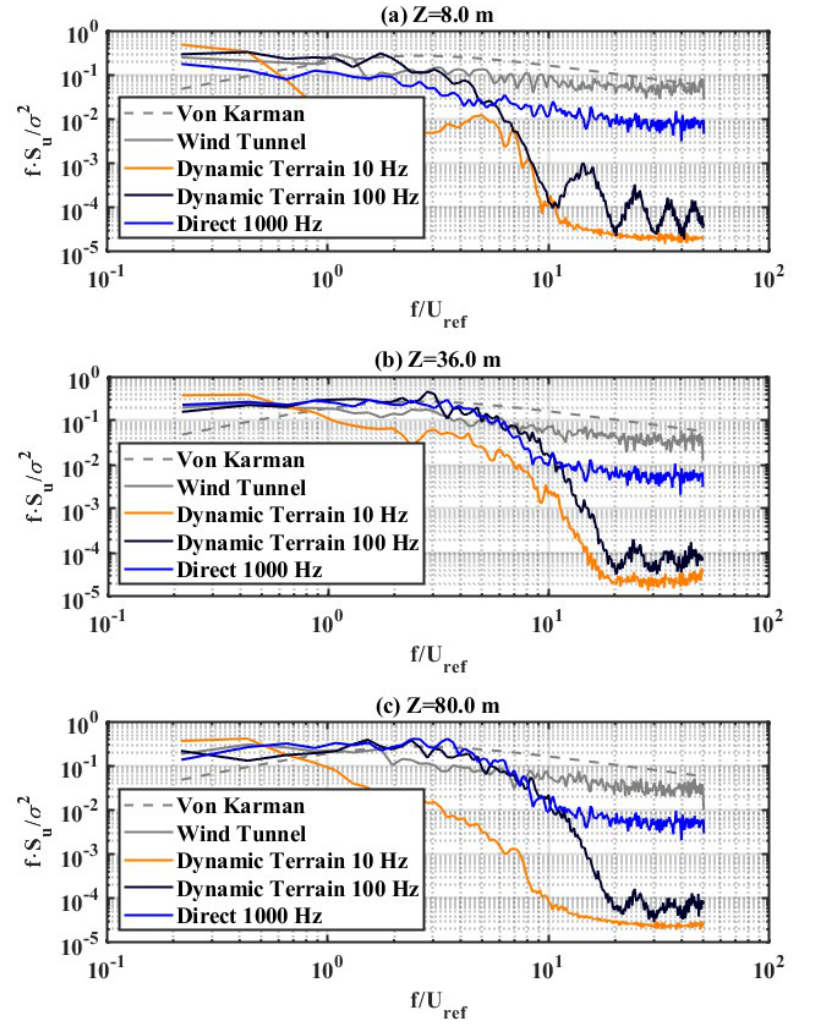
Figure 11. Spectrum of longitudinal velocity from von Karman, as extracted from wind tunnel and calculated from dynamic terrain 10 Hz, dynamic terrain 100 Hz, and direct method at C for ( a ) 8.0 m, ( b ) 36.0 m, and ( c ) 80.0 m